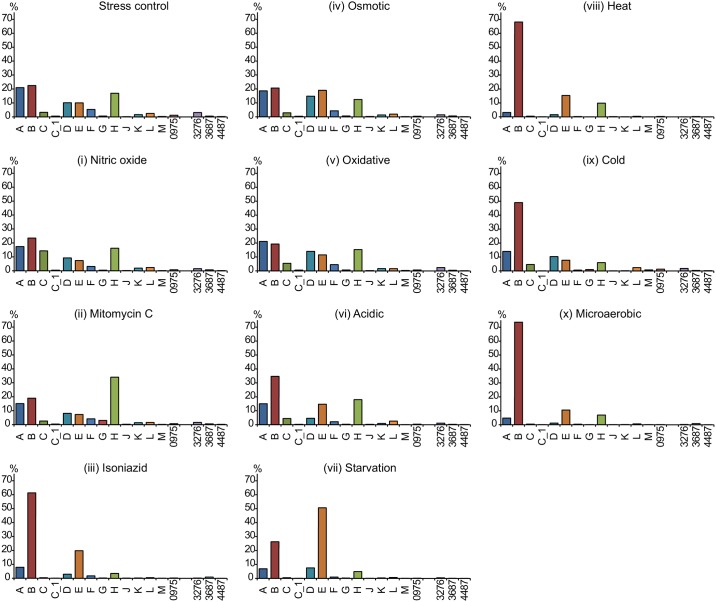
Distribution of σ-factor mRNAs in M. marinum CCUGrfp exposed to various stresses.Cells were grown to exponential phase in liquid Middlebrook 7H9 medium followed by exposure to different stressors for 24 hours as indicated (except for microaerobic stress which lasted for 12 days; see Materials and Methods for details). The distribution (from RNASeq data) was calculated and plotted as described in figure legend 2. The roman numerals refer to the different stress conditions; for details, see main text.